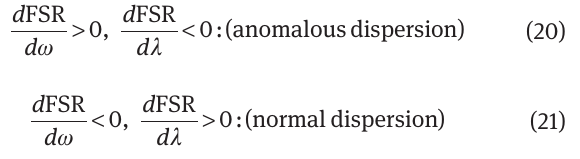
ric geometries (i.e. spheroids and toroids). Accordingly, method (FEM) simulation is widely used to derive the with commercially available software (e.g. COMSOL Mul- tiphysics) as an eigenvalue solver of axisymmetric struc- tures. A detailed calculation including both material and geometric dispersion is described later.